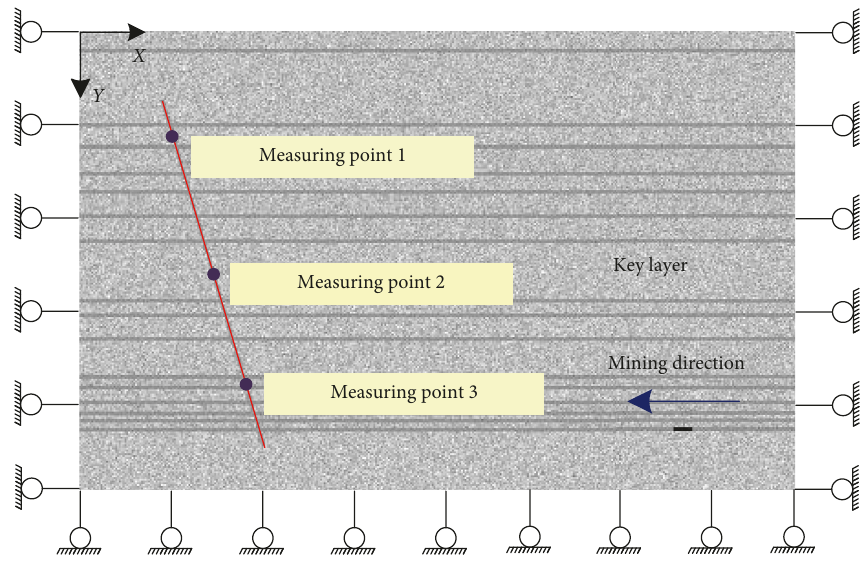
Figure 6: Schematic illustration of numerical model and excavation